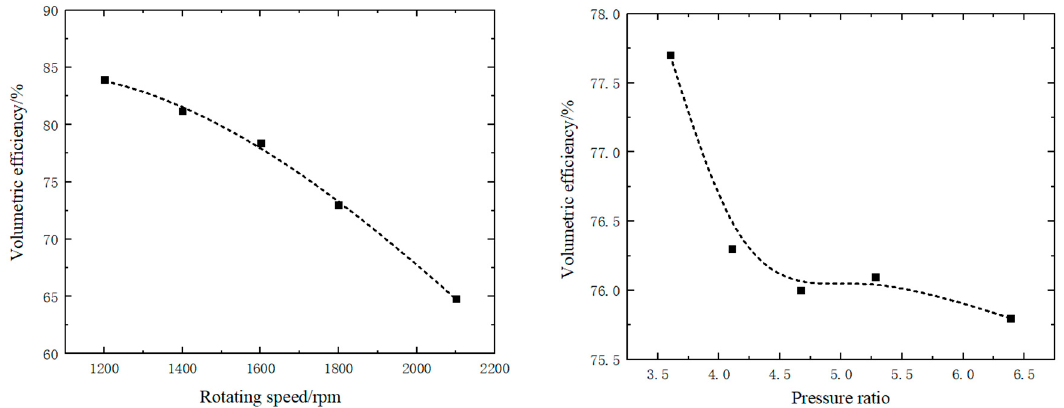
Figure 14. Volumetric e ffi ciency of the scroll compressor coated with DLC film.